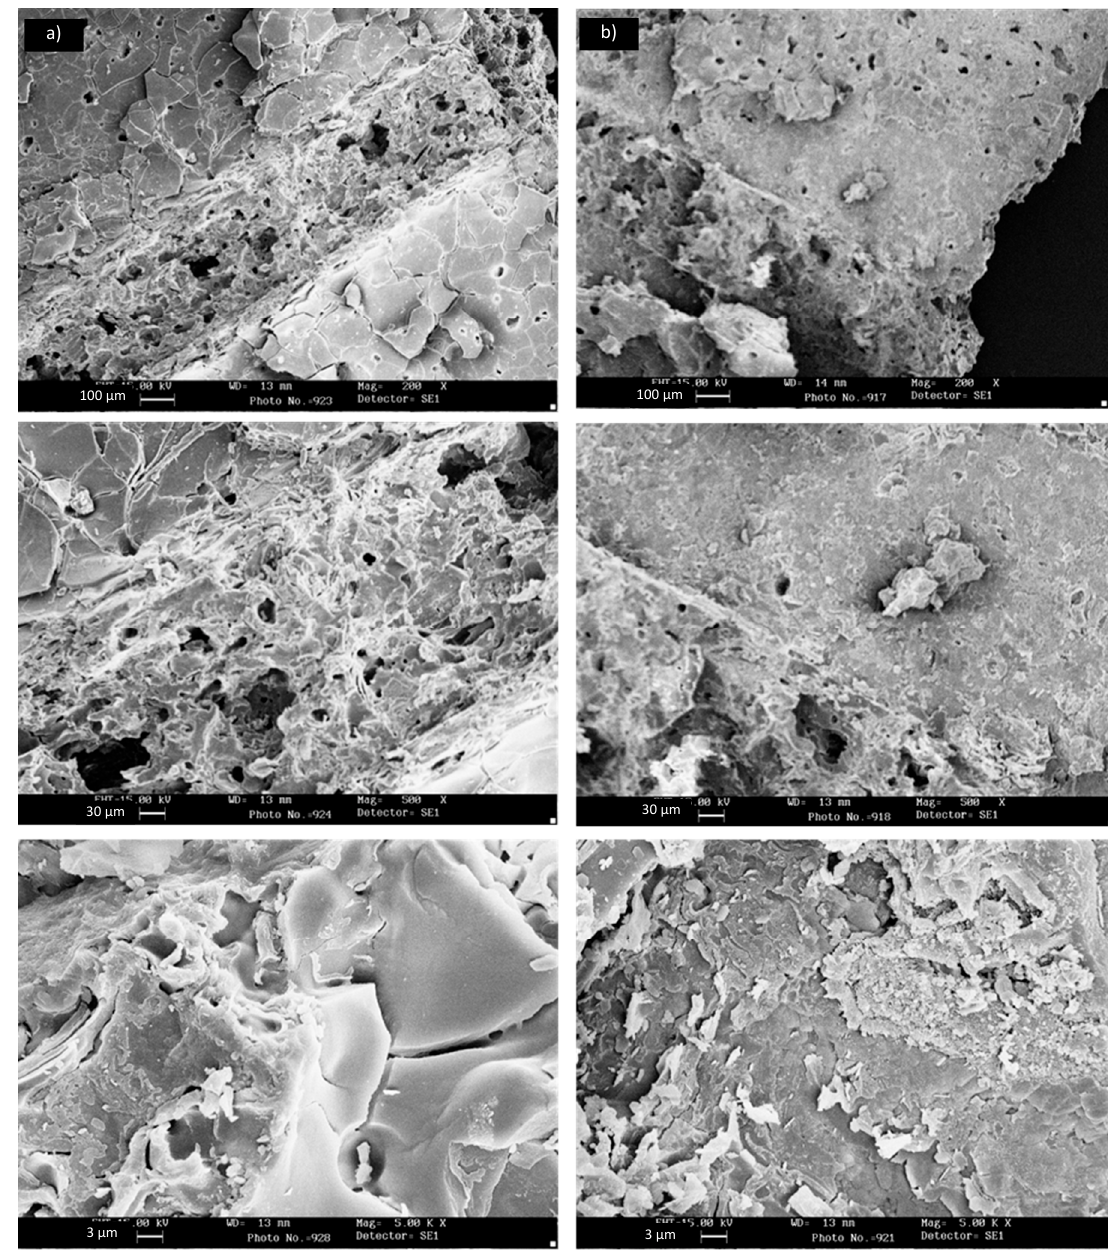
Figure 1. SEM images of cordierite before ( a ) and after the washcoat deposition ( b ).